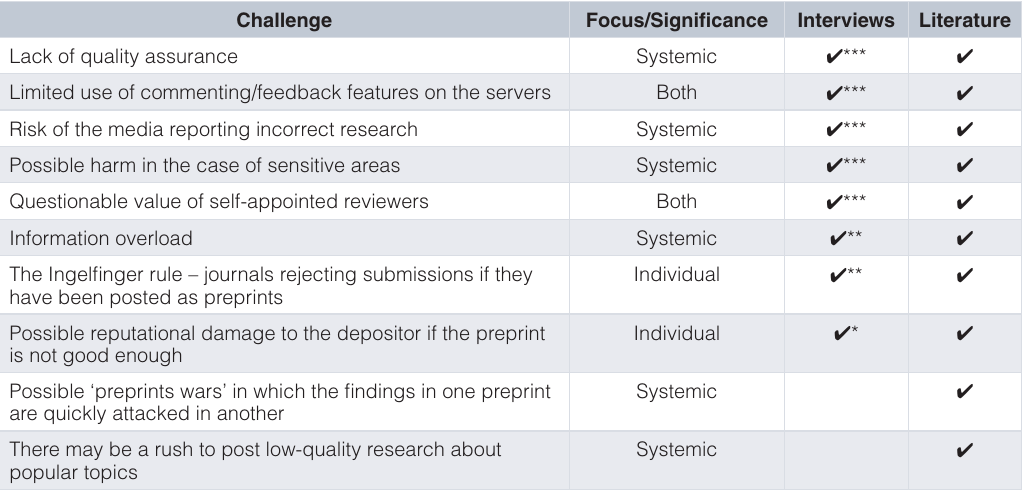
Table 6. Potential challenges of preprints. Mentions across the entire dataset: ✔ *** =over 20 mentions; ✔ ** =between 10 and 20 mentions; ✔ * =fewer than 10 mentions. “Systemic” significance relates to those factors with system-wide impact e.g. the broad scholarly communication system or disciplinary community; “individual” relates to those factors primarily affecting individuals or small